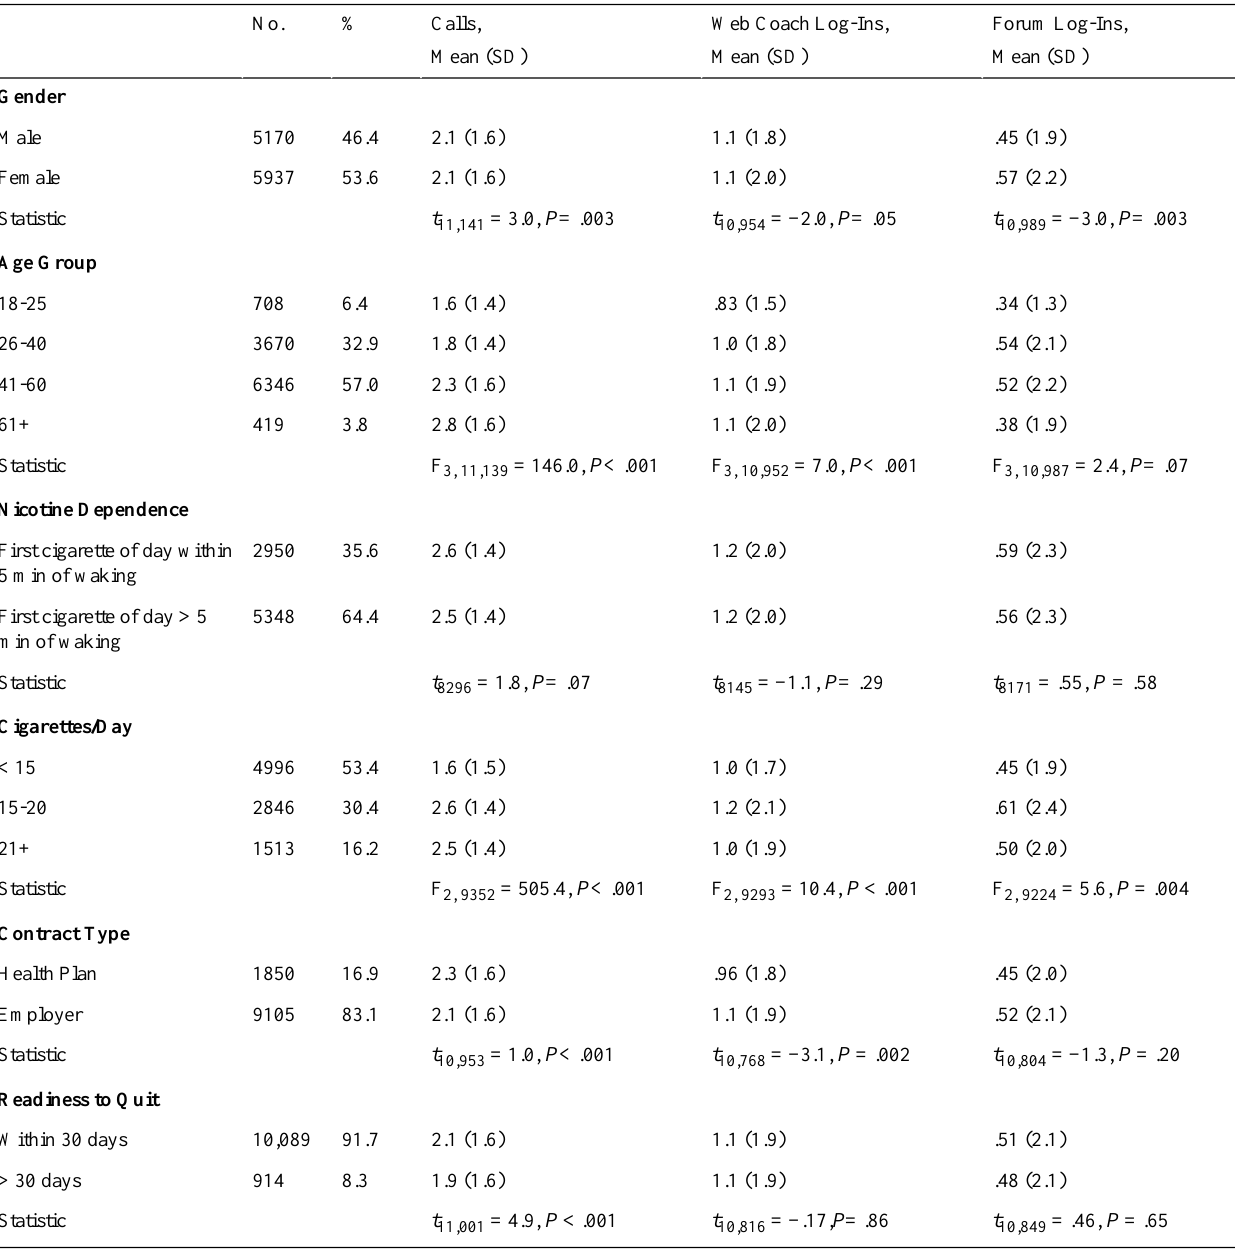
Table 2. Web Coach and calls completed, by characteristic (N = 11,143). Numbers cited in statistics vary due to missing data for some analyses.